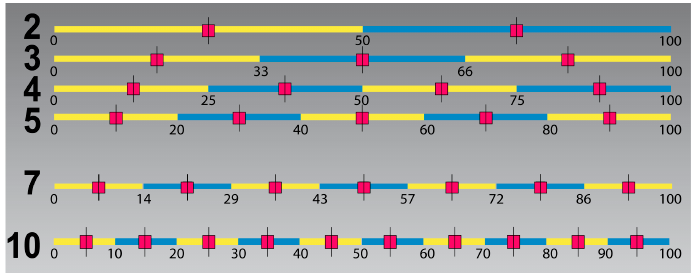
Figure 2. How noise annoyance scales with a different number of scale points partition a continuous noise annoyance indicator going from 0 to 100 given that the scale partitions are equal in size and cover the whole range of responses.